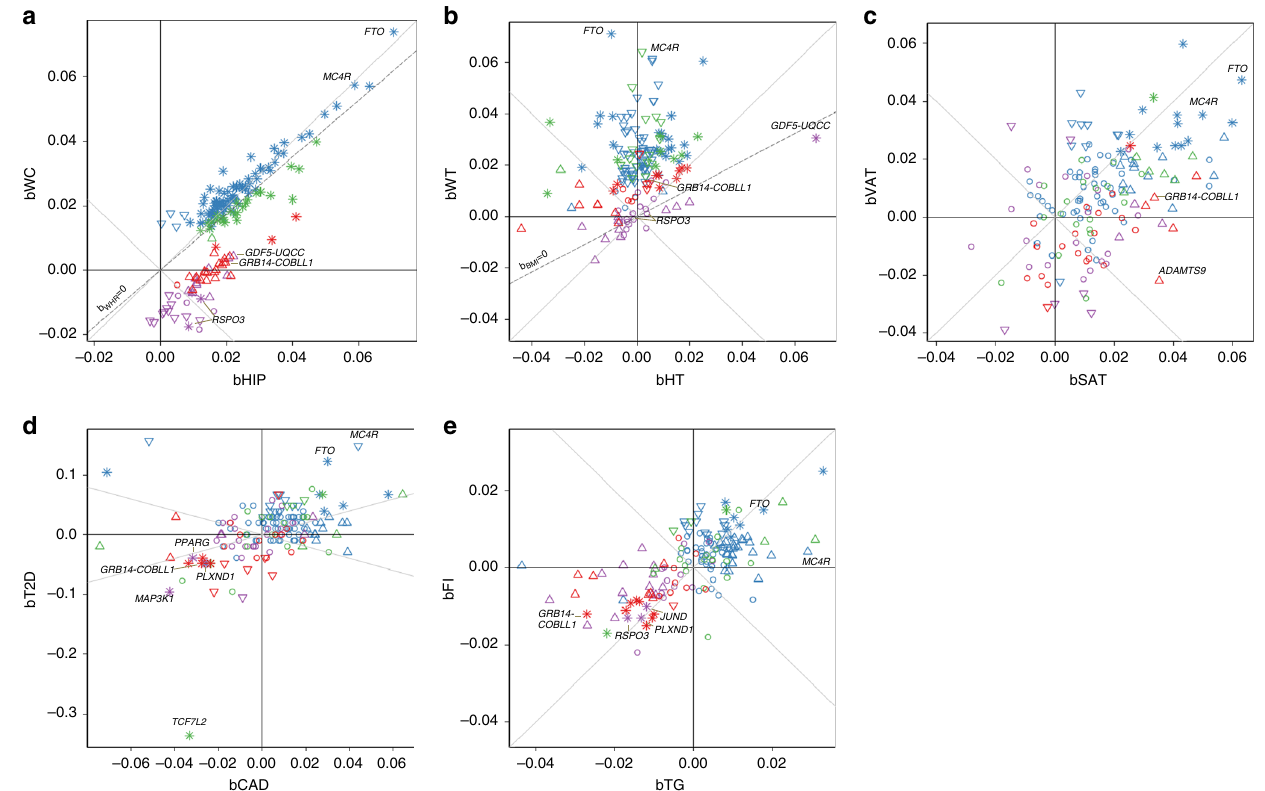
Fig. 4 Anthropometry, fat depots and cardio-metabolic traits. The fi gure shows the co-associations for the 159 variants for pairs of traits (from GIANT, DIAGRAM 15 , GLGC 16 , MAGIC 17 , CARDIoGRAMplusC4D 18 ): a waist circumference (WC) and hip circumference (HIP), b weight (WT) and height (HT), c visceral adipose tissues (VAT) and subcutaneous adipose tissue (SAT), d type 2 diabetes (T2D) and coronary artery disease (CAD), e fasting insulin (FI) and triglycerides (TG). Coloring indicates the four classes: BMI + WHR + (blue), BMIonly + (green), WHRonly − (purple), and BMI + WHR − (red). Symbols indicate nominal signi fi cance for y axis trait only (downward triangle), the x axis trait only (upward triangle), or both (stars). In a , the dashed line indicates a null effect for WHR (slope estimated as b WC / b HIP = mean(WHR), mean(WHR) = 0.88 from CoLaus); in b , the dashed line indicates the null effect for BMI (slope estimated as b WT / b HT = 2*mean(height)*mean(BMI)*SD(height)/SD(WT) = 0.54, using estimates from